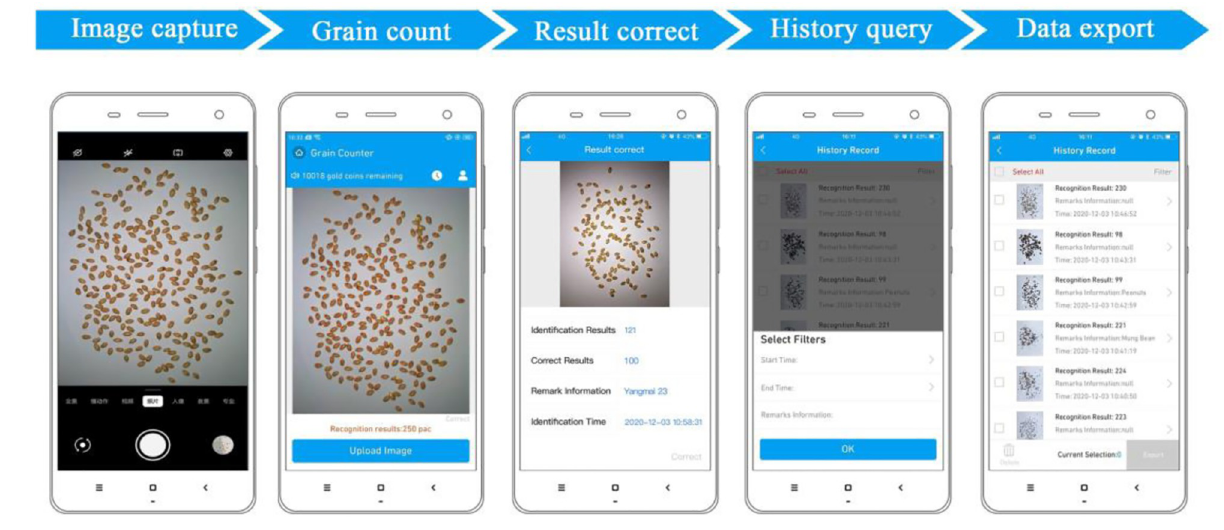
Fig 11. Flow-chart diagram of the system.